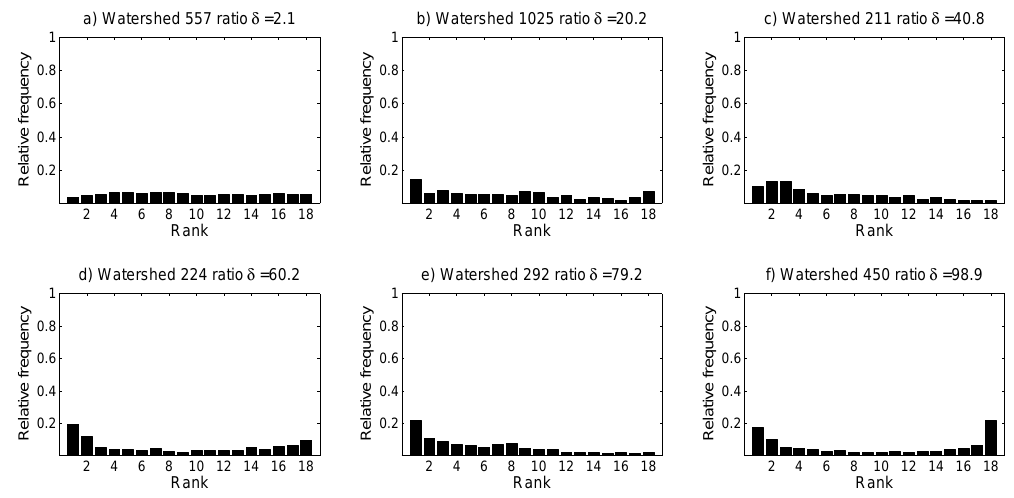
Fig. 5. Six examples of rank histograms with their ratio δ